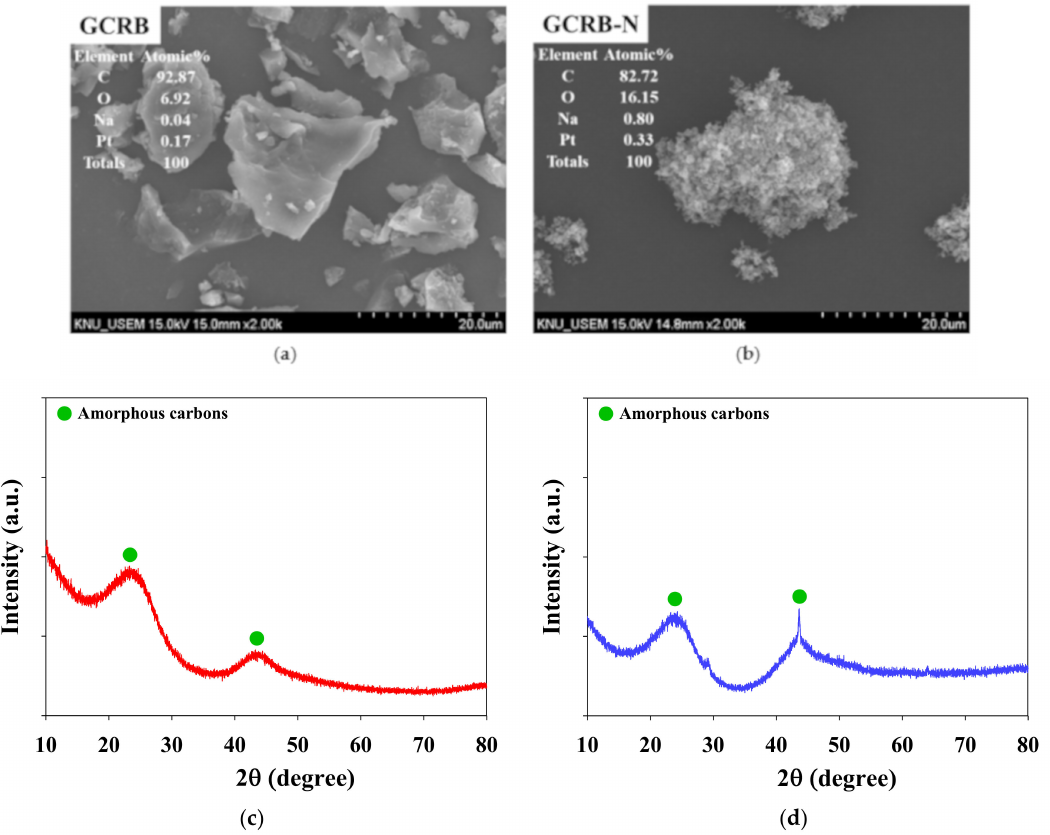
Figure 4. The SEM images of the ( a ) GCRB and ( b ) GCRB-N (magnification = 2000), and the XRD spectra of the ( c ) GCRB and ( d )